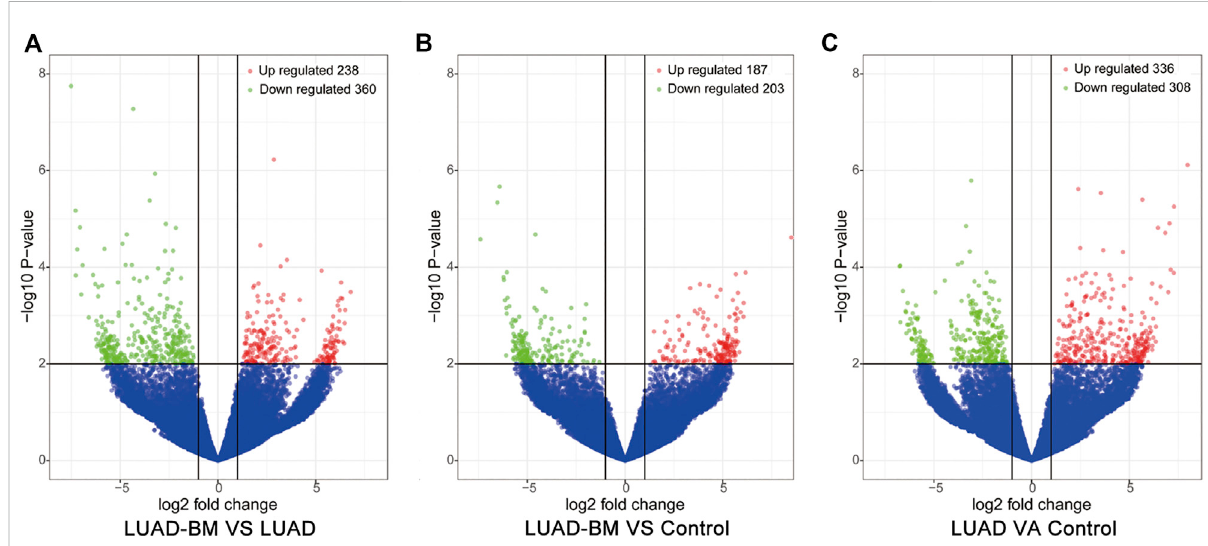
FIGURE 2 Volcano plots of differentially expressed circRNAs in peripheral blood among different groups. (A) The differentially expressed circRNAs between LUAD-BM and LUAD. (B) The differentially expressed circRNAs between LUAD-BM and healthy individuals. (C) The differentially expressed circRNAs between LUAD and healthy individuals. Red and green dots indicate upregulated and downregulated circRNAs, respectively. LUAD-BM, lung adenocarcinoma with bone metastasis; LUAD, lung adenocarcinoma; circRNAs, circular